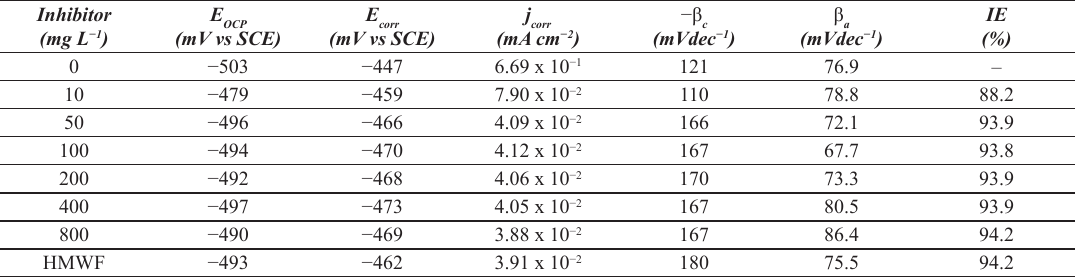
Table 6. Electrochemical parameters acquired from Tafel’s extrapolation for mild steel in 1 mol L −1 HCl in the absence and presence of CSE. Inhibitor (mg L −1 )